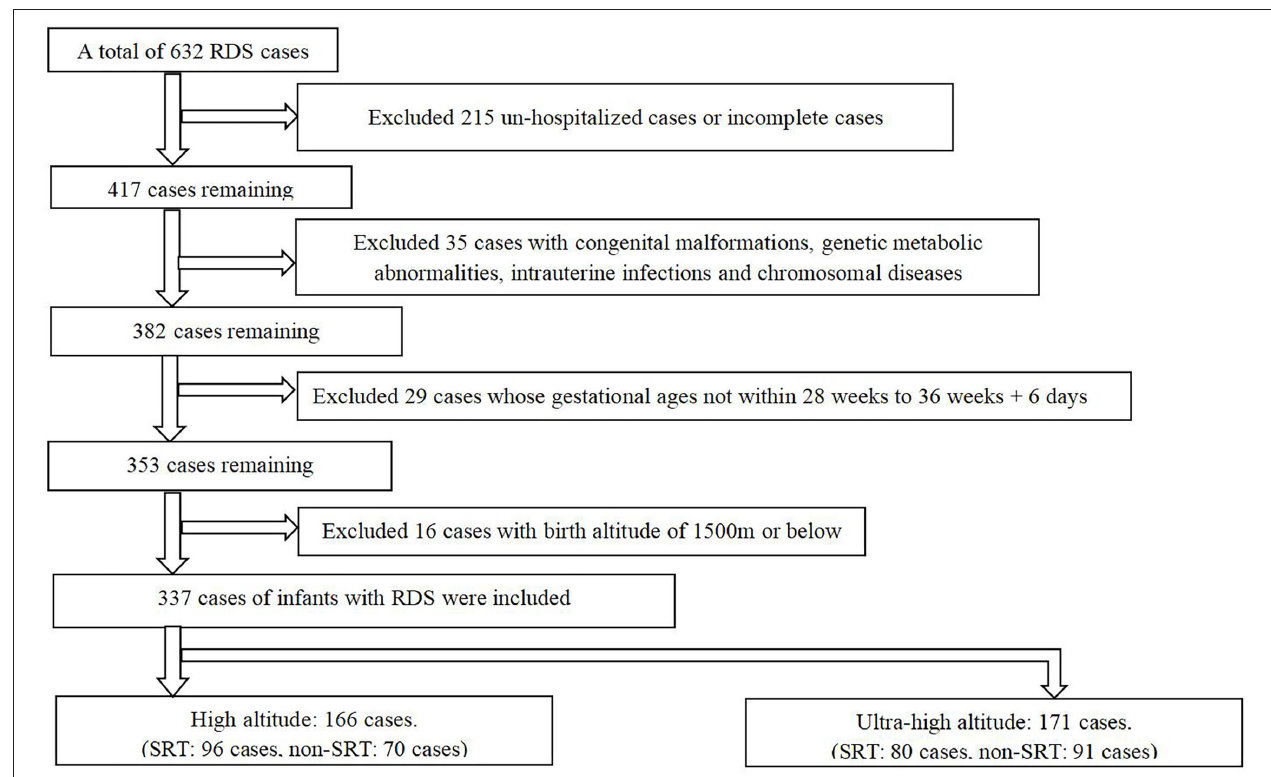
FIGURE 1 | Qualitative and basic sample exclusion (RDS, respiratory distress syndrome; SRT, surfactant replacement